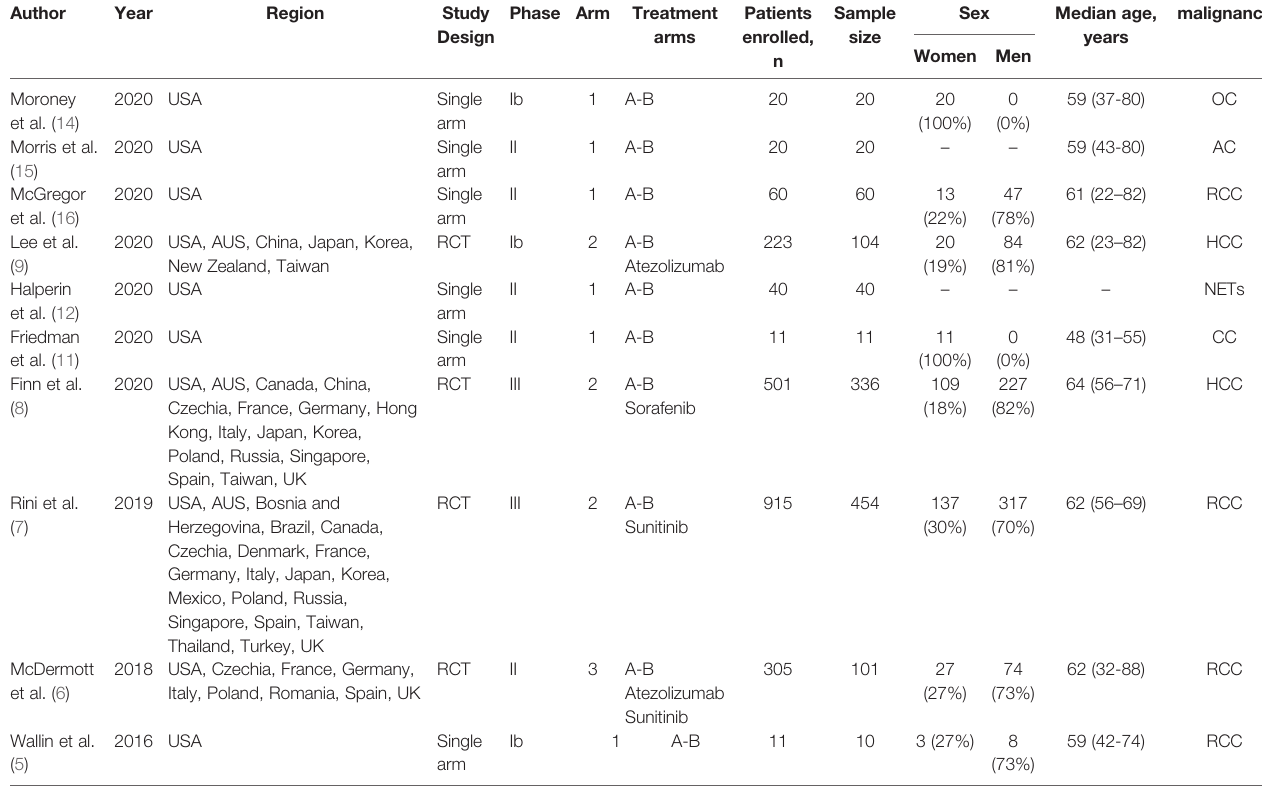
TABLE 1 | Characteristics of the trials and patients included in the